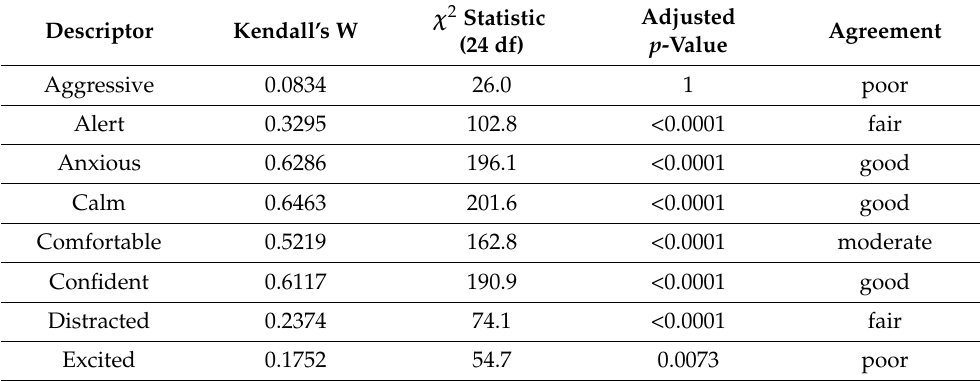
Table 3. Inter-rater agreement analysis (Kendall’s W and adjust p -values with Bonferroni procedure) and agreement